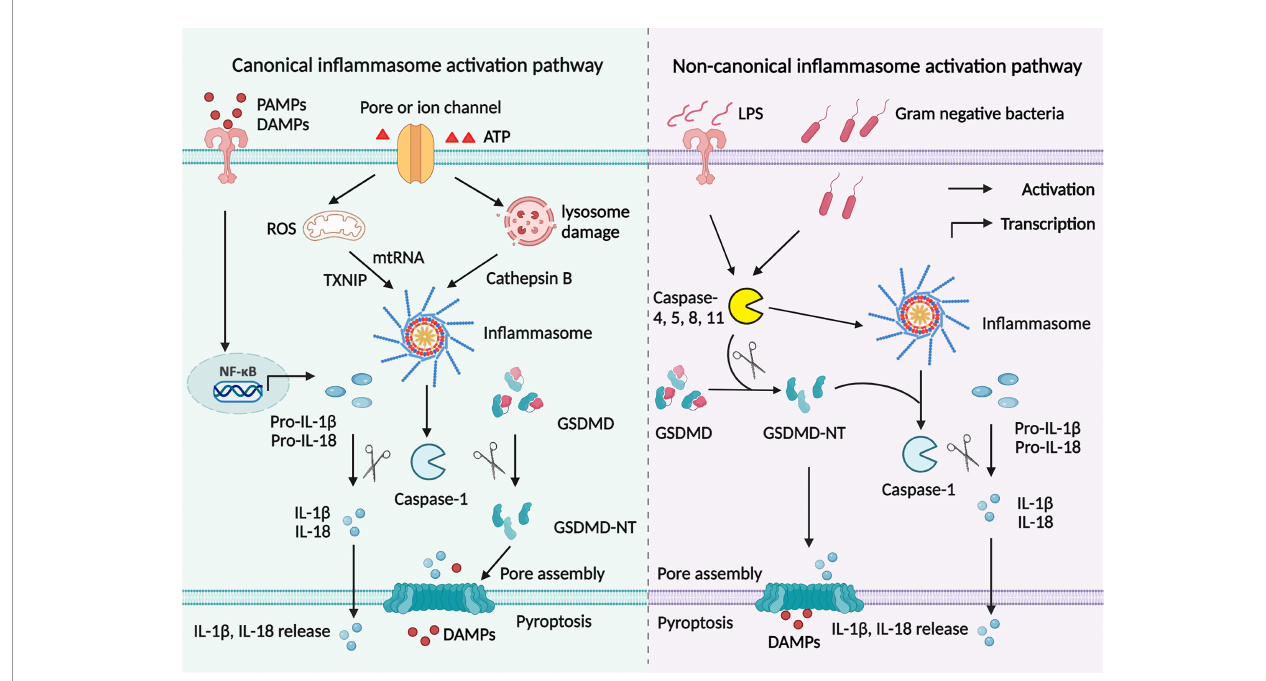
FIGURE 2 | Canonical and non-canonical signaling pathways to activate in fl ammasomes. Canonical signaling pathway to activate in fl ammasomes is mediated by two signaling steps. The priming step involves PAMPs or DAMPs binding to TLRs to initiate NF- k B signaling pathway, which promotes pro-IL-1 b and pro-IL-18 production. Then endogenous danger signals activate in fl ammasome assembly and caspase-1 in the second step. Active caspase-1 cleaves GSDMD into GSDMD- NT; cut pro-IL-1 b and pro-IL-18 into mature IL-1 b and IL-18. The GSDMD breaks a pore on the cell membrane to help IL-1 b and IL-18 secretion. There are three main mechanisms involved in in fl ammasome activation. Extracellular ATP binds to the P2X7 receptor and causes potassium ef fl ux and NLRP3 activation. Uric acid and amyloid are endocytosed in a lysosome-dependent manner, promoting lysosome rupture and cathepsin B release and resultant in fl ammasome assembly. TXNIP and mtDNA accumulation in a ROS-dependent manner activates in fl ammasomes. However, in the non-canonical signaling pathway, intracellular LPS or toxin initiates caspase-11, promoting in fl ammasomes assembly and caspase-1 activation. Then both active caspase-11 and caspase-1 cleave GSDMD into GSDMD-NT, leading to cascaded reactions similar to the canonical signaling